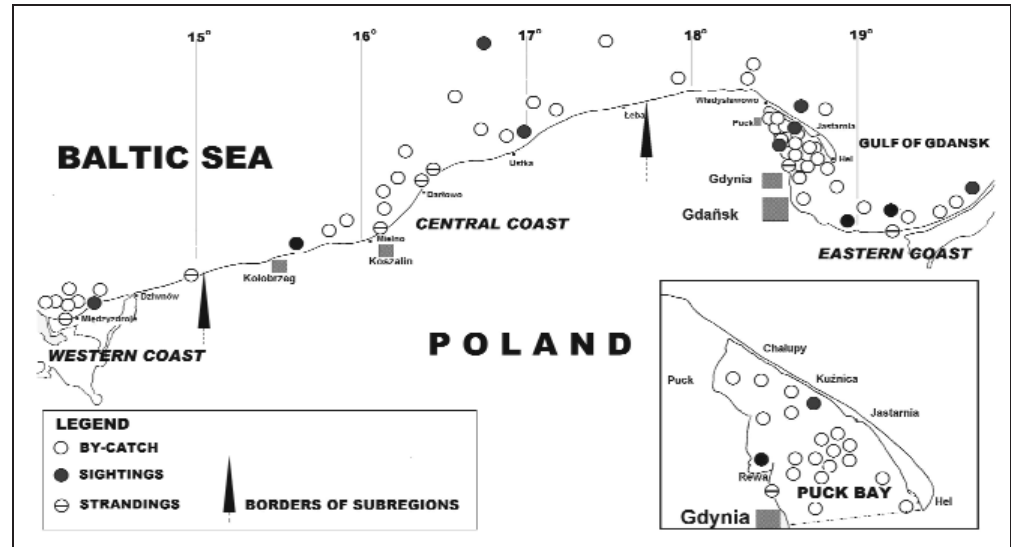
Fig. 3. Seasonal variation in by- catch rates in relation to the total number of all reports on harbour por- poise occurrence in Polish Baltic waters (includ- ing bycatch, strandings and sightings) during 1990-1999, and closed seasons for different fish species in Polish Baltic fishery (in arrows: >4M – closed season outside the zone of 4 nautical miles, <4M – inside the coastal zone of 4 nautical miles).